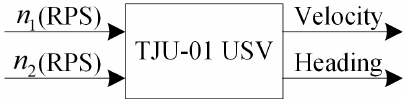
Figure 2. Block diagram of the propulsion system.